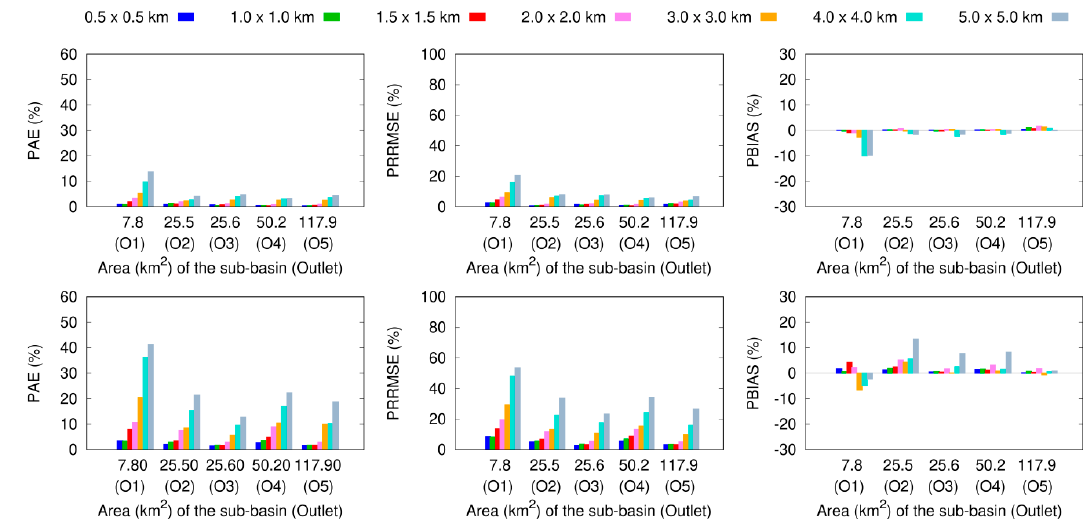
Figure 15. Percent absolute error, percent relative root mean square error, and percent bias profiles of